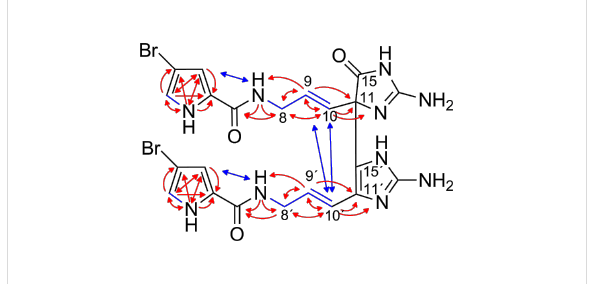
Figure 2: Selected 1 H, 1 H-COSY (blue bonds), 1 H, 1 H-NOESY (blue arrows), 1 H, 13 C-HMBC, and 1 H, 15 N-HMBC (both red arrows) correla- tions for citrinamine A ( 1